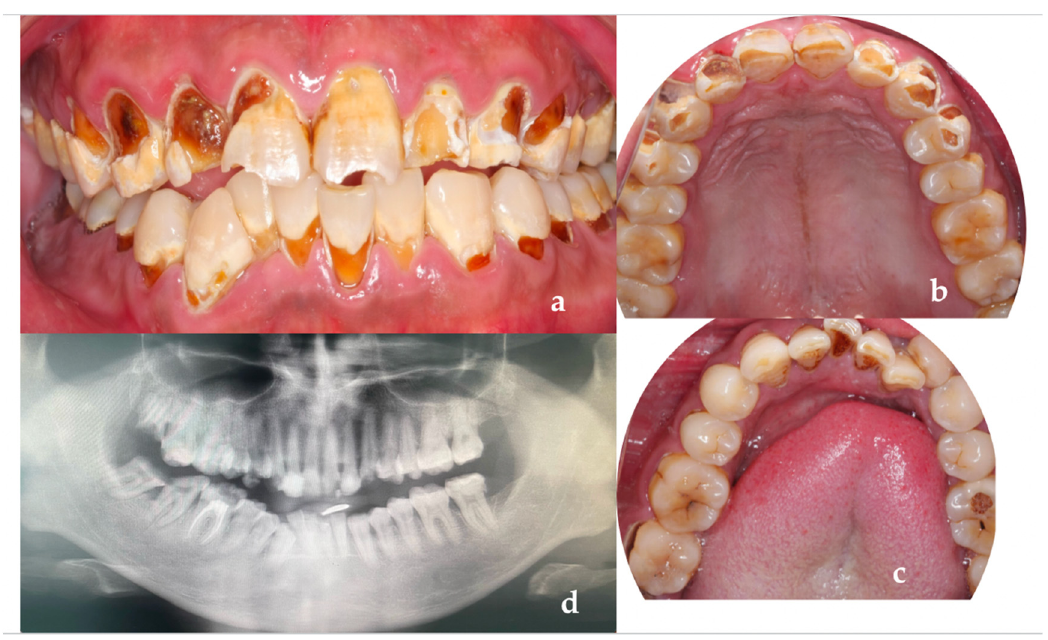
Figure 2. ( a ) The photograph of the patient at first visit; ( b ) Upper teeth; ( c ) Lower teeth; ( d ) Panoramic X-ray of the patient (after the root canal therapy of teeth 46).